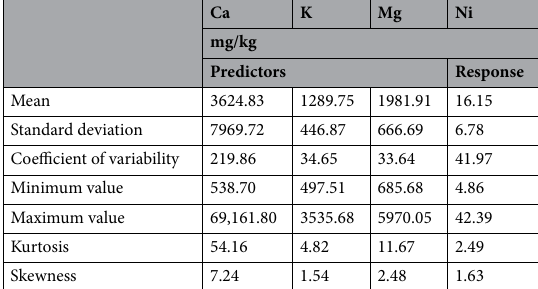
Table 1. Statistical description of predictors and